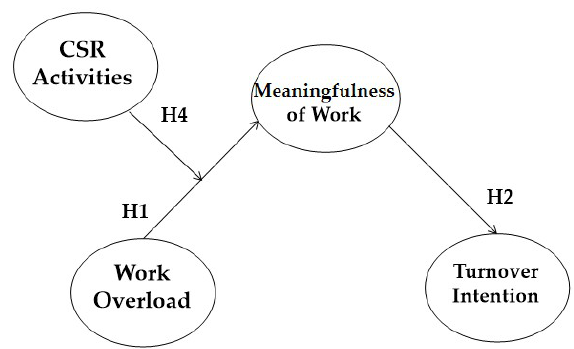
Figure 1. Theoretical